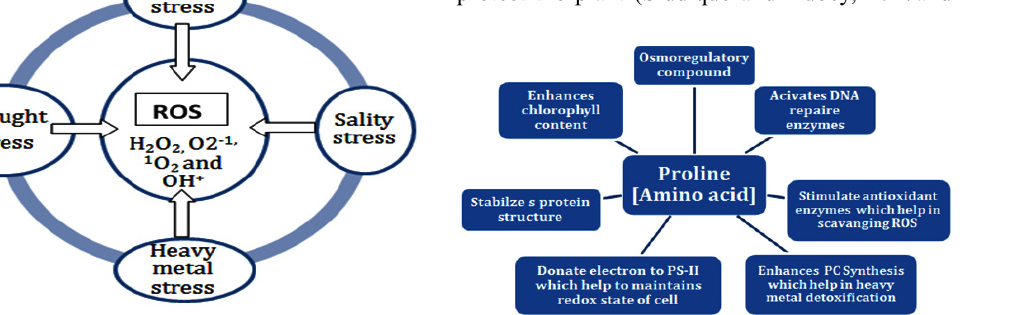
Fig. 3. Multifunctional role of proline under various kind of stress in plant (Source: Adopted from Abbas, et al .,